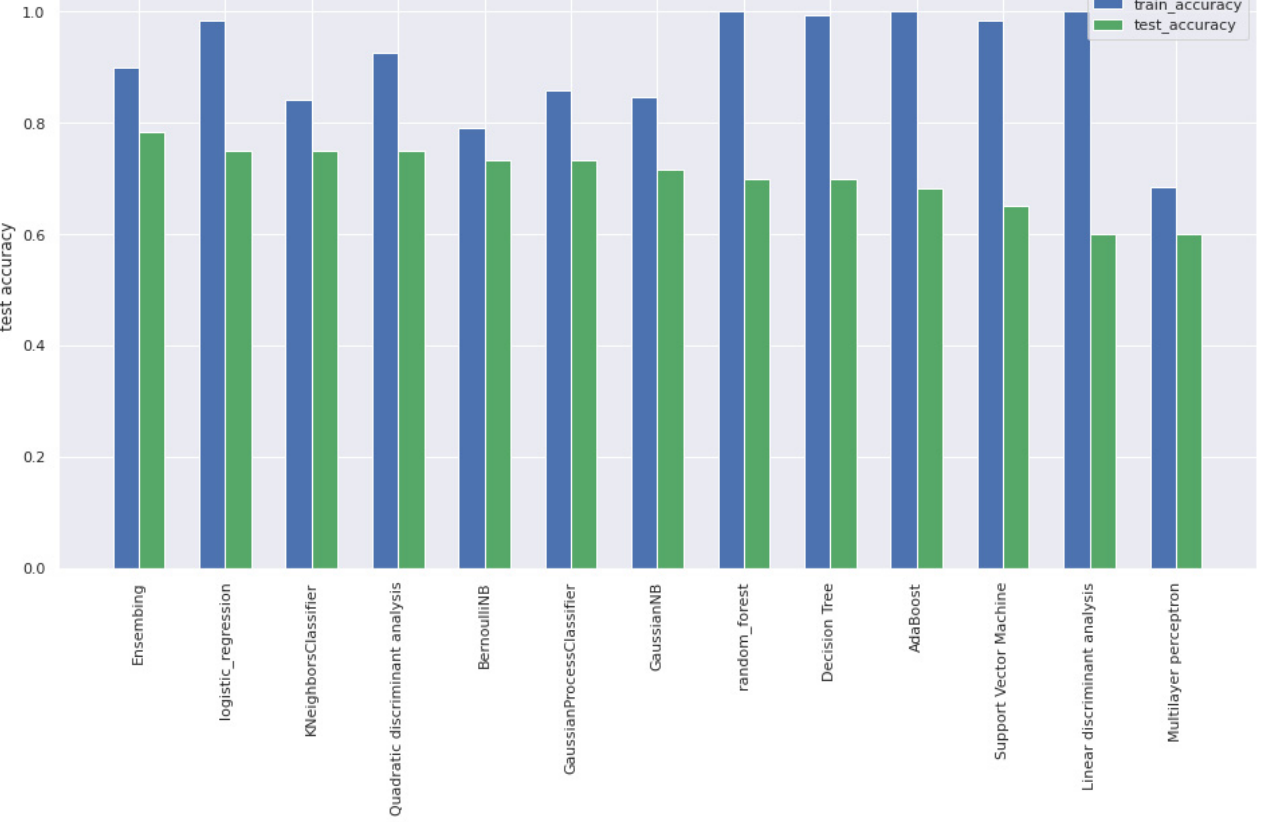
Figure A6. Pair plot of all the score of the analysis 1—Remobi Meaningful reading dataset.